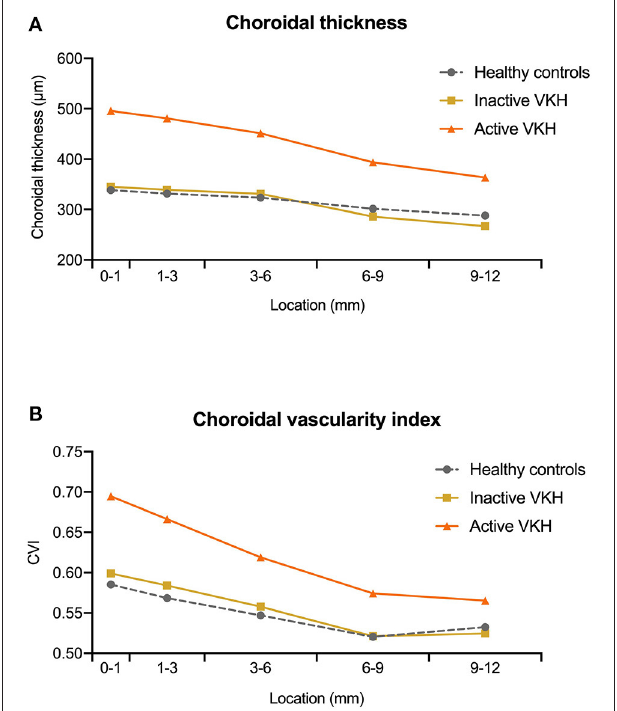
FIGURE 2 | The median value of (A) choroidal thickness and (B) choroidal vascularity index (CVI) measured at different locations (0–1, 1–3, 3–6, 6–9, and 9–12mm rings) within the 12mm × 12mm optical coherence tomography angiography (OCTA) scans in healthy controls, inactive Vogt-Koyanagi-Harada (VKH), and active VKH